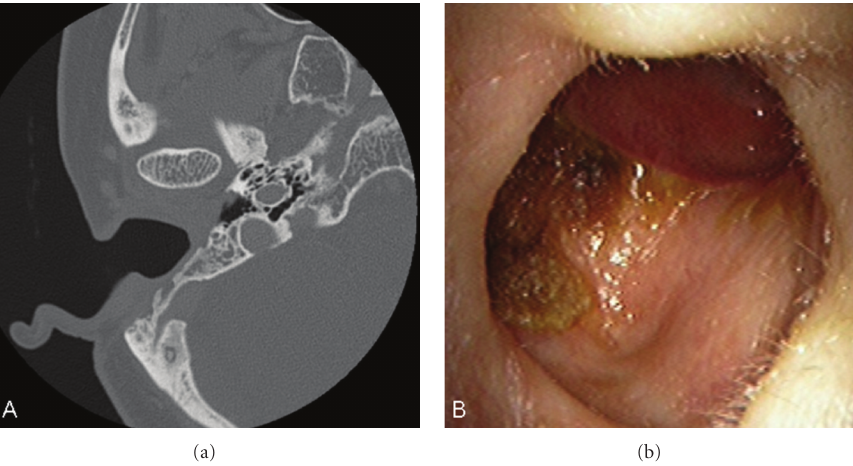
Figure 1: Six months after surgery in Case 1. (a) An axial CT image showed that the EAC had formed an open cavity with the mastoid bowl. (b) Although no stenosis or bone exposure was observed, a wet mucosal membrane and the crust were shown in the opened mastoid cavity.